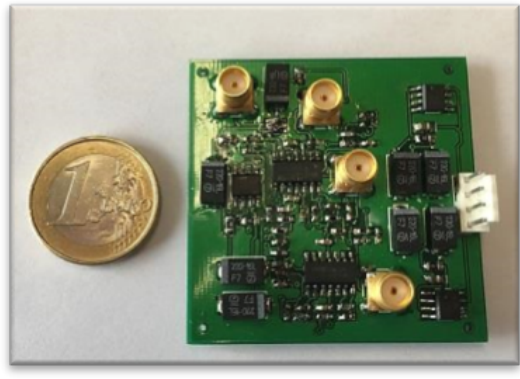
Figure 16. Actual synchronous